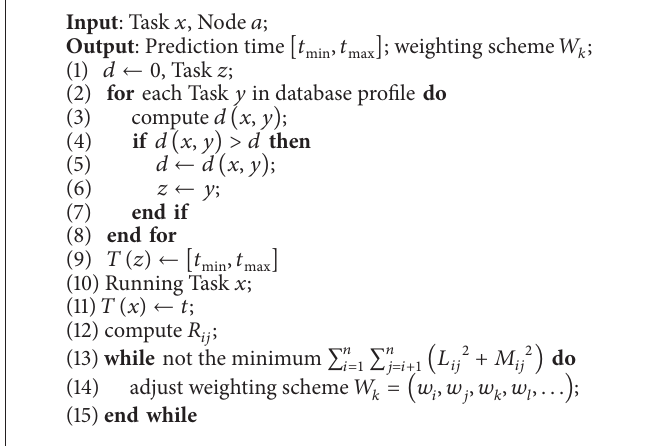
Algorithm 1: Algorithm for task execution time